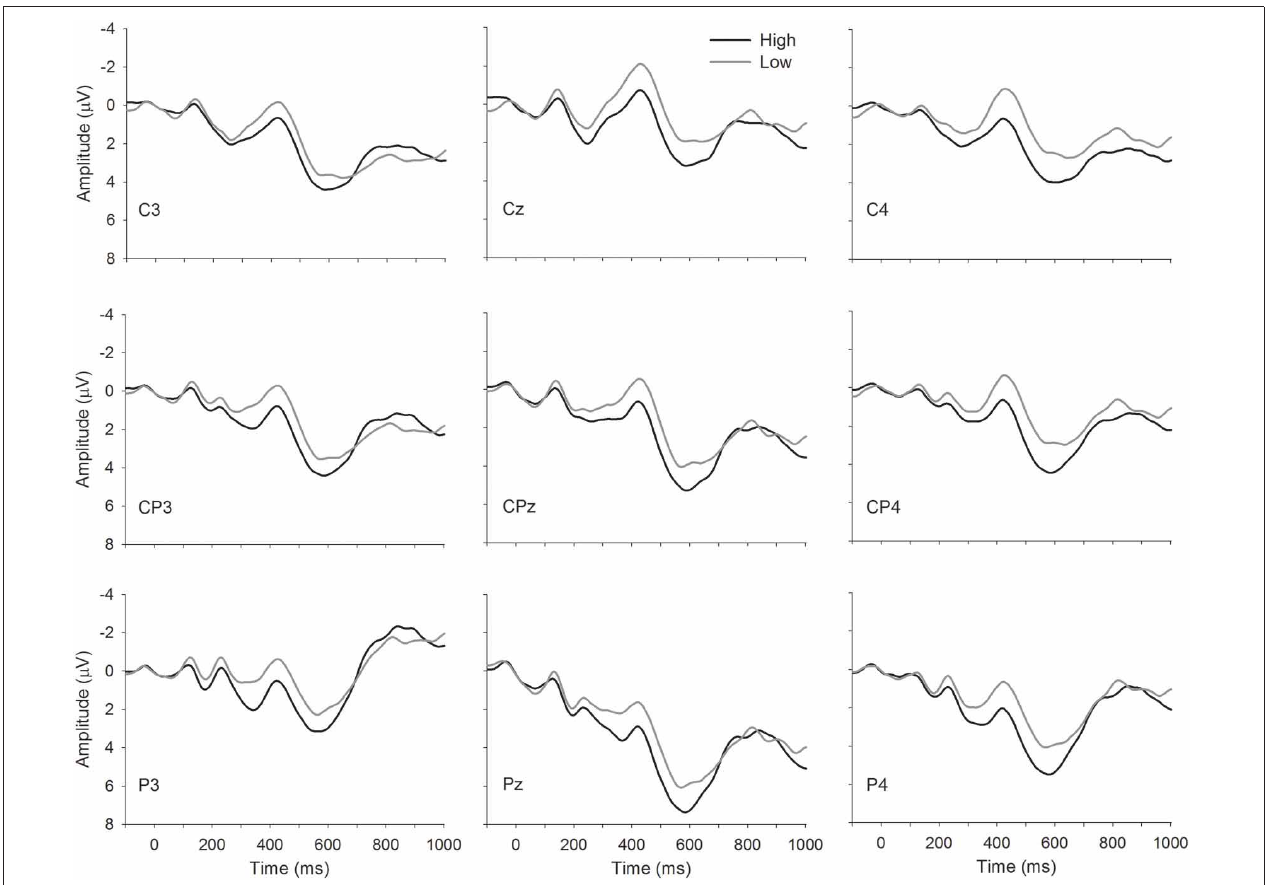
FIGURE 1 | Grand average waveforms showing high- and low-sense items. Time is plotted on the x -axis and amplitude in microvolts on the y -axis; following convention, negative amplitudes are plotted